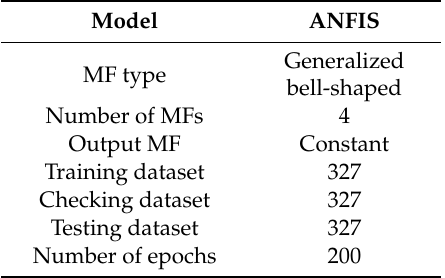
Table 2. Configurations of the applied ANFIS algorithm